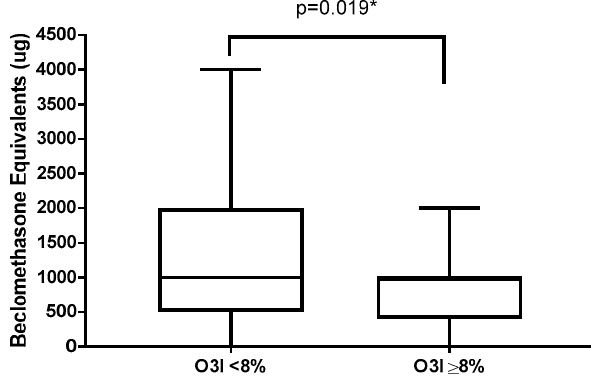
Figure 2. Inhaled corticosteroid dose classified by omega-3 index status. * Logistic regression adjusting for age, BMI and gender.